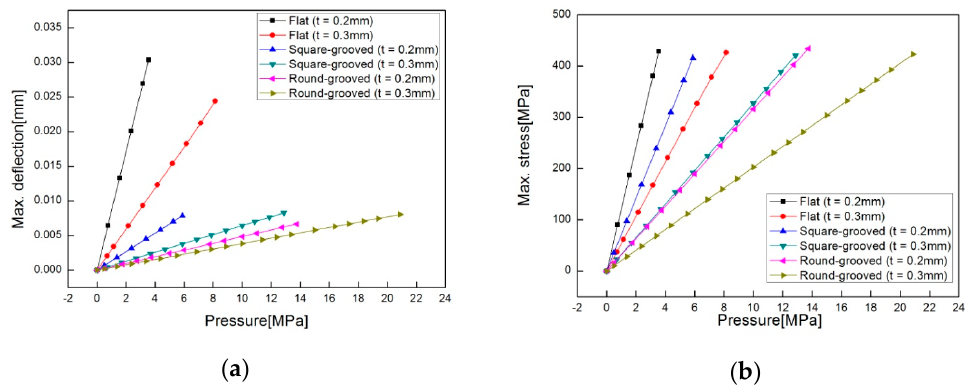
Figure 8. Comparison of maximum deflection/stress against pressure among flat, square-grooved, and round-grooved types with w = 1.05 mm: ( a ) maximum deflection, ( b ) maximum stress.